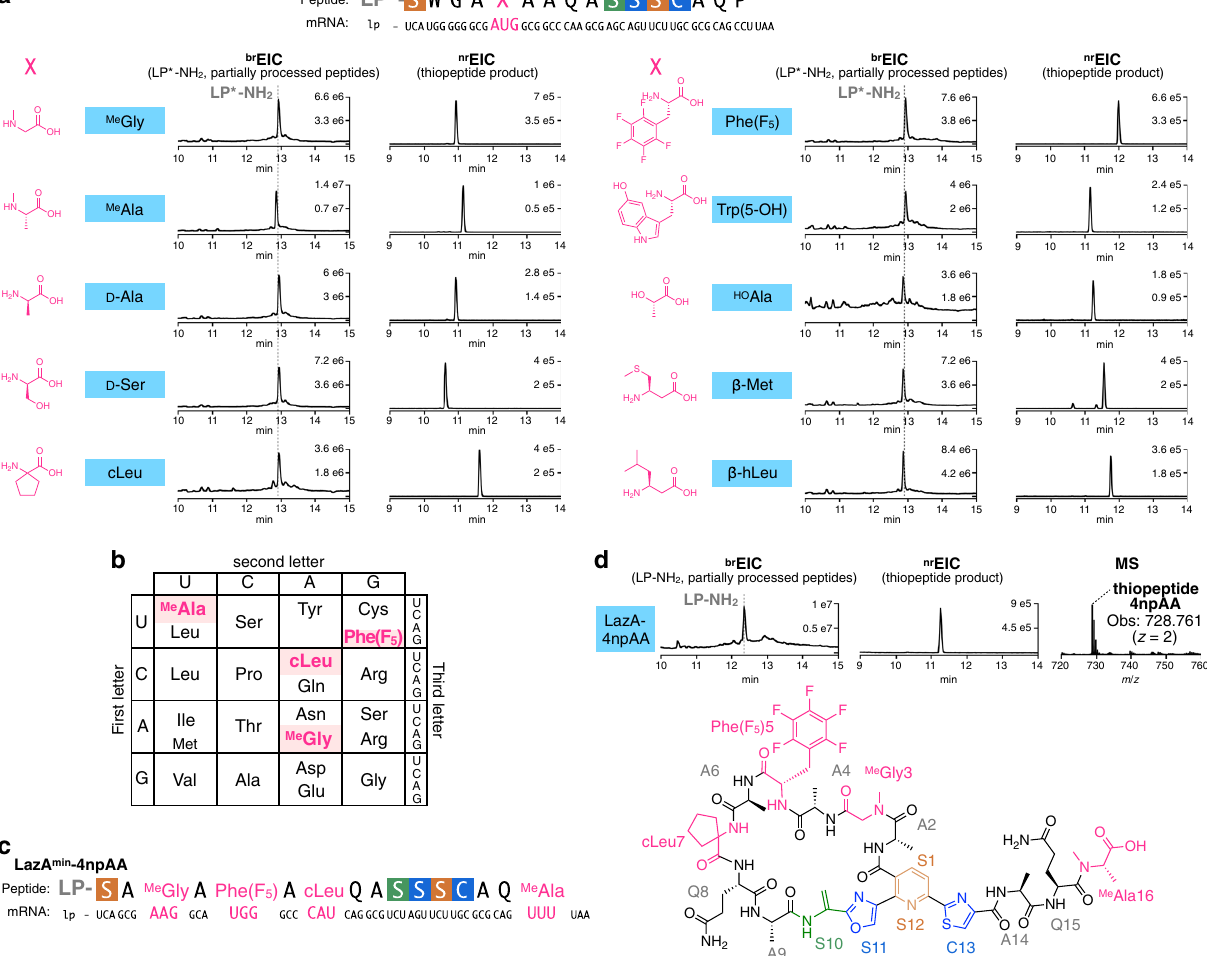
Fig. 5 Synthesis of hybrid thiopeptides by genetic code reprogramming with the FIT-Laz system. a Incorporation of a single npAA in a permissible position 5 of LazA min using the Met AUG codon. LazA min mutants accessed with in-vitro genetic code reprogramming were treated with the full enzyme set and the reaction outcomes were analyzed by LC-MS. Displayed are LC-MS chromatograms ( br EIC chromatograms on the left showing partially processed linear peptides and LP * -NH 2 after enzymatic treatment, and nr EIC chromatograms on the right for expected thiopeptides generated at m / z 0.10 tolerance window). LP * stands for LazA LP sequence where formyl-Met is replaced with N -biotinylated-Phe (see Supplementary Methods for details). b Reprogrammed genetic code utilized for the synthesis of an arti fi cial lactazole containing four npAAs and c its mRNA sequence. d LC-MS chromatograms as in a for the enzymatic processing of the LazA min variant from c , and the chemical structure of the resulting thiopeptide. Taken together, these data suggest that diverse hybrid thiopeptides are accessible with the FIT-Laz